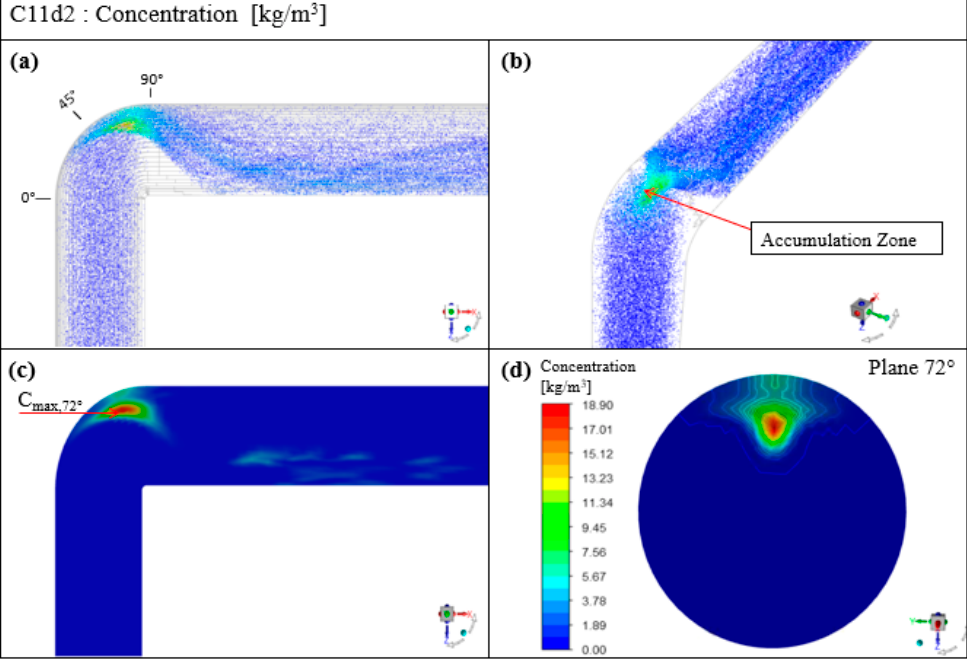
Figure A7. Results of particle concentration. Case C11d2. ( a ) Instant positioning of the X-Z plane particles ( b ) Instant positioning of the particles in 3D view ( c ) Concentration contour in the X-Z plane of the mid-section of the pipe ( d ) Concentration contour in the Z-Y plane of the maximum concentration cross section. Snapshots are taken for a statistically steady flow.